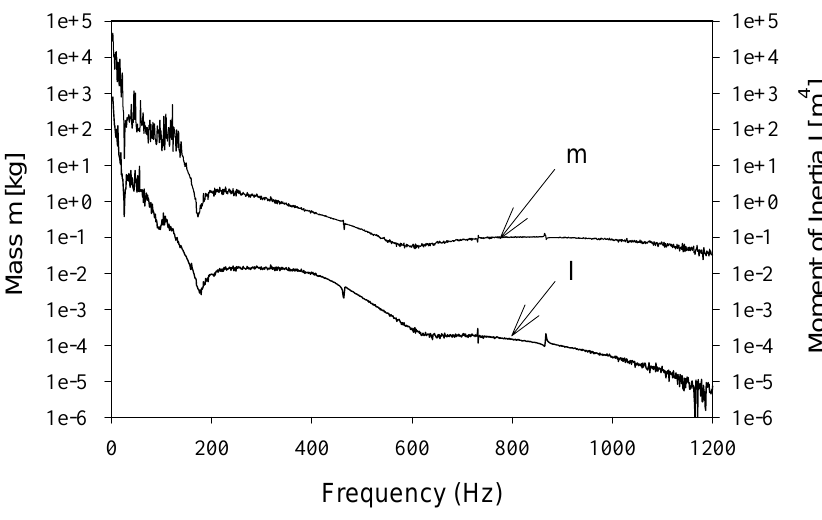
Fig. 10. Predicted equivalent mass and the mass moment of inertia for the equivalent bolt-joint